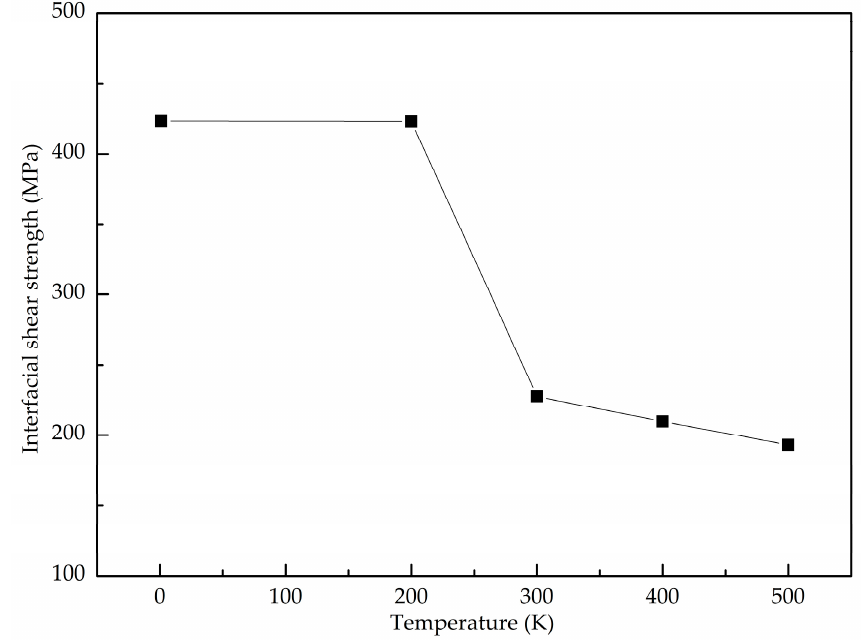
Figure 12. Interfacial shear strength under different temperatures.